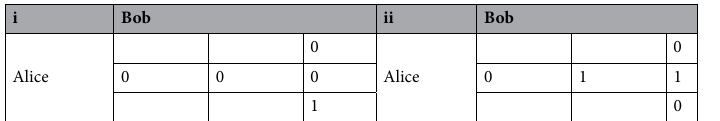
Table 1. Two possible winning instances for players Alice and Bob, if they are given a = 2 and b = 3 , respectively. They will win if Alice can fill the second row as { 0, 0, 0 } and Bob the third column as { 0, 0, 1 } , or { 0, 1, 1 } and { 0, 1, 0 } corresponding to the final matrices shown on left (i) and right (ii), respectively.